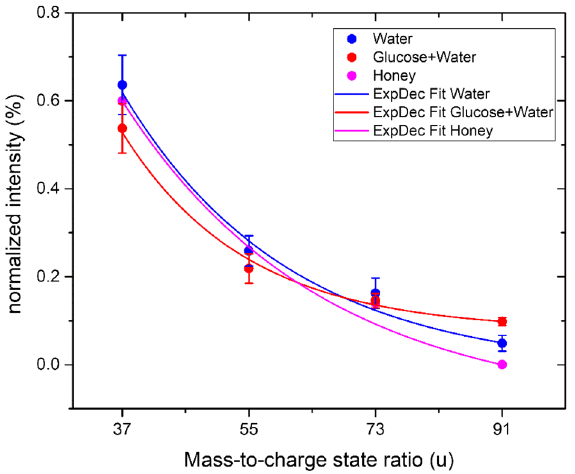
Figure 3. Relative peak intensities of the molecule (H 2 O) n H + with n = 1–5 from a pure water measurement, glucose solution and honey are plotted against the respective mass-to-charge state